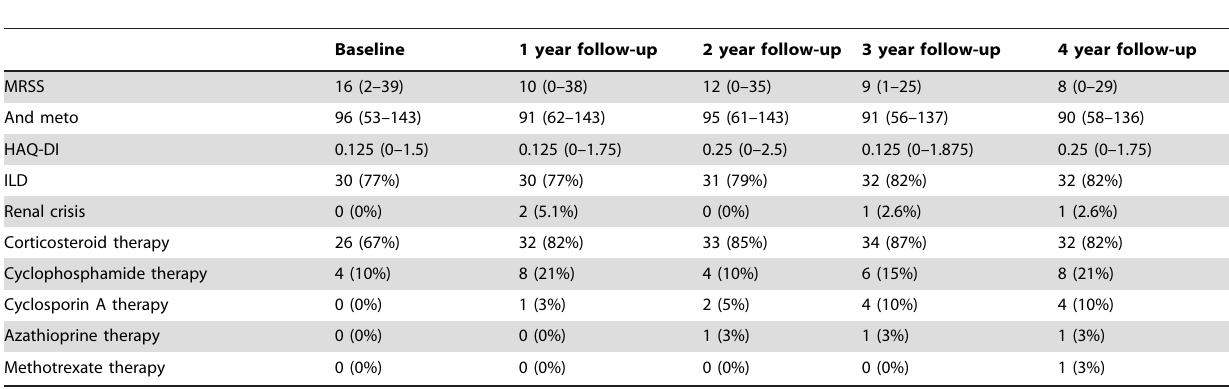
Table 1. The course of clinical and laboratory features in patients with